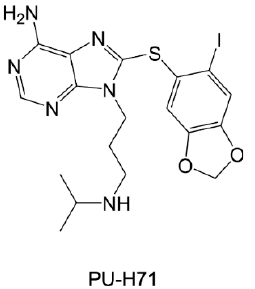
Figure 16. Chemical structure of PU-H71